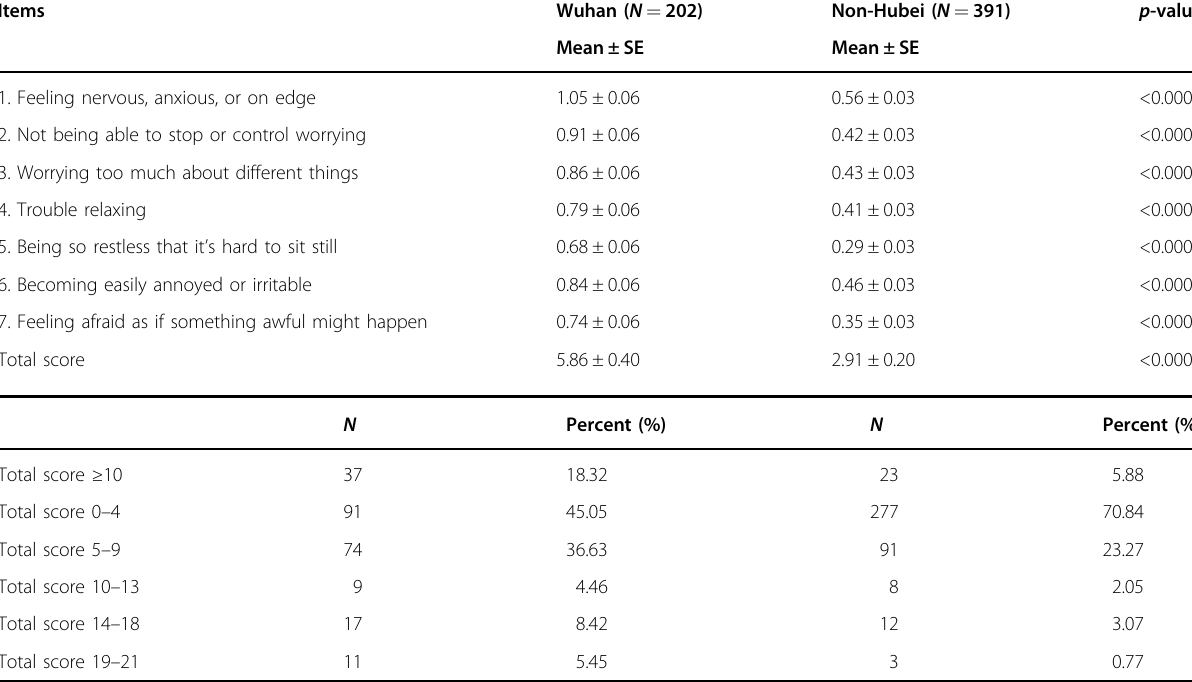
Table 4 Outcomes of GAD-7 for nurses.